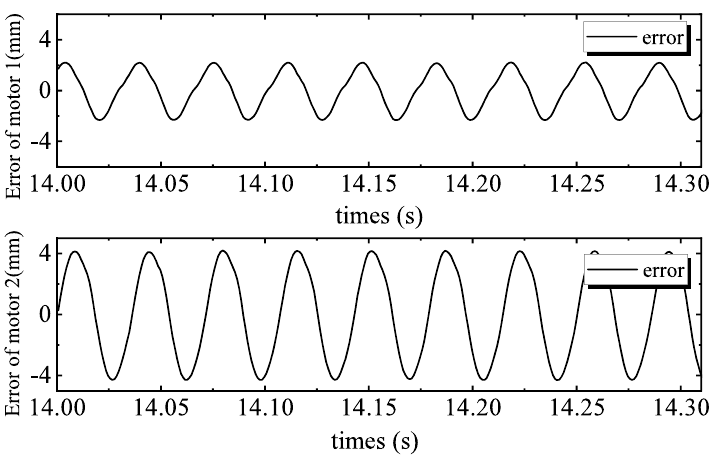
Figure 5. PID tracking errors of two